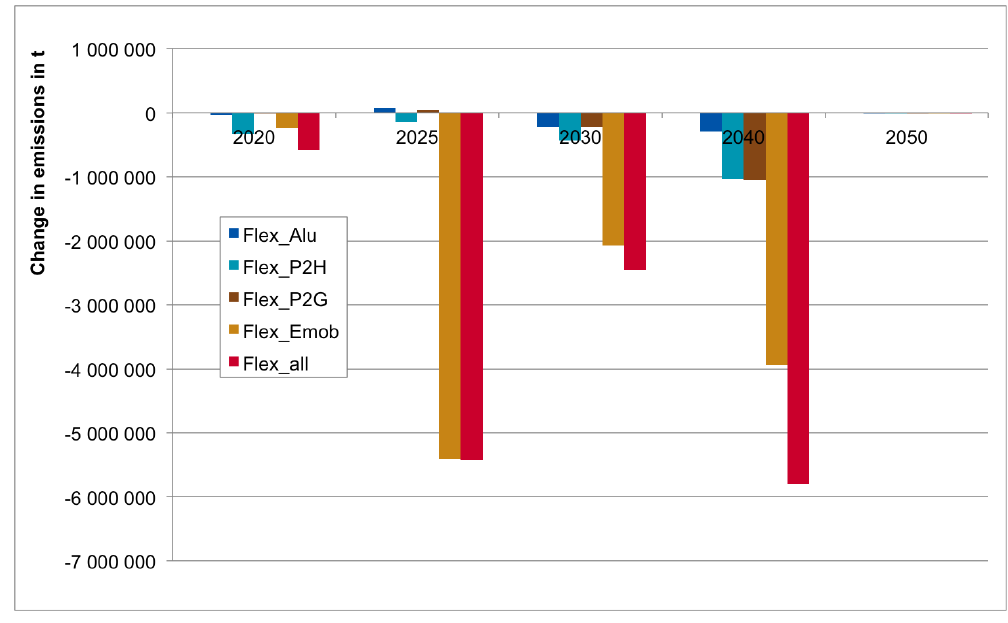
Figure 7. Change in emissions vs. reference. Table 4. Total emissions in mio